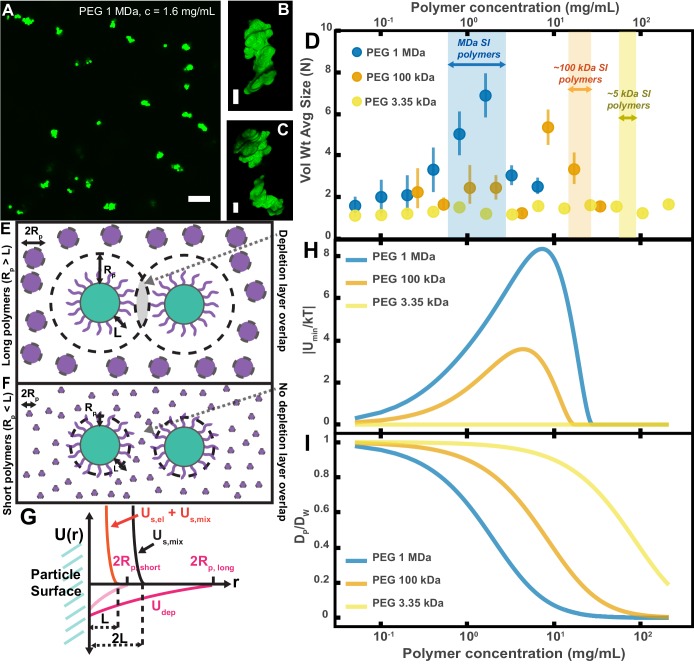
Aggregation of PEG-coated particles in model polymer solutions shows complex dependence on molecular weight (MW) and concentration of PEG.(A) Aggregates of 1 µm diameter PEG-coated particles in a 1 MDa PEG solution with a polymer concentration (c) of 1.6 mg/mL. Image is a maximum z-projection of 10 optical slices taken on a confocal microscope. Scale bar is 10 µm. (B and C) 3D renders of aggregates found in panel A. Scale bars are 2 µm. (D) Volume-weighted average sizes for serial dilutions of PEG solutions of three MWs (1 MDa, 100 kDa, and 3350 Da). Volume-weighted average sizes are plotted on the vertical axis in terms of number of particles per aggregate (N) against polymer mass concentration (cp) in mg/mL. The vertical error bars are 95% empirical bootstrap CI (see Materials and methods for bootstrapping procedure). Shaded regions indicate the concentration ranges of detected intestinal polymers of similar MW. (E) Schematic depicting depletion interactions induced by ‘long polymers’ (polymer radius (RP) >length of the brush, L). Free polymers are depicted as purple spheres. Colloids are depicted in green with the grafted brush layer in purple. The depletion layer around each colloid is depicted by dashed lines. The overlap region between the two depletion layers is indicated in grey. (F) Schematic depicting depletion interactions induced by ‘short polymers’ (Rp <L). The depletion zone does not extend past the length of the brush and there is effectively no overlap in the depletion layers; the depletion attractions are ‘buried’ within the steric layer. (G) Schematic depicting the different contributions to the inter-particle potential (U(r)) against inter-particle separation distance (r). The hard surfaces of the particles are in contact at r = 0. Udep depicts the depletion potential for a short polymer (RP,short) and a long polymer (RP,long). Us,mix shows the contribution to the steric potential due to mixing. Us,el + Us,mix shows the contribution due to elastic deformations and mixing at close inter-particle separations. (H) The magnitude of the minima of the inter-particle potential (Umin/kT) plotted against polymer concentration for the three PEG solutions in (D). (I) Diffusion coefficients estimated from the Stokes–Einstein–Sutherland equation for 1 µm particles in the PEG solutions used in (D). Diffusion coefficients of particles in polymer solutions (DP) are normalized by the diffusion coefficients in water (DW) and plotted against polymer concentration.